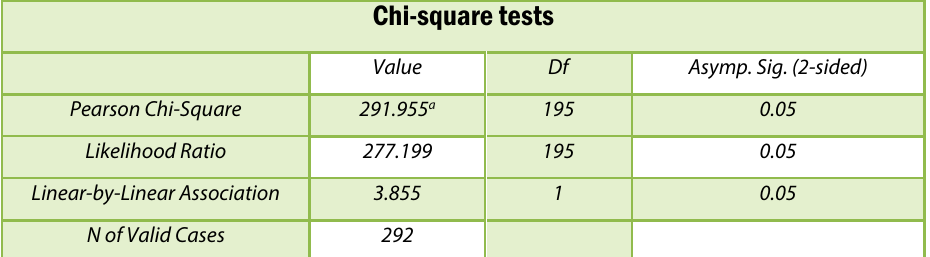
Table 4: A Cross Tabulation Covering X 2 Calculation and P-Value Used in Testing the Cases of Political-administration interface in Southwest